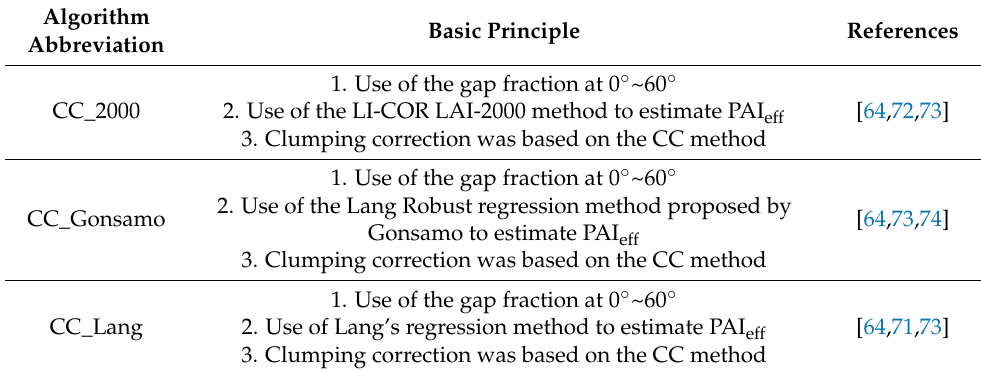
Table 4. PAI true algorithms in the